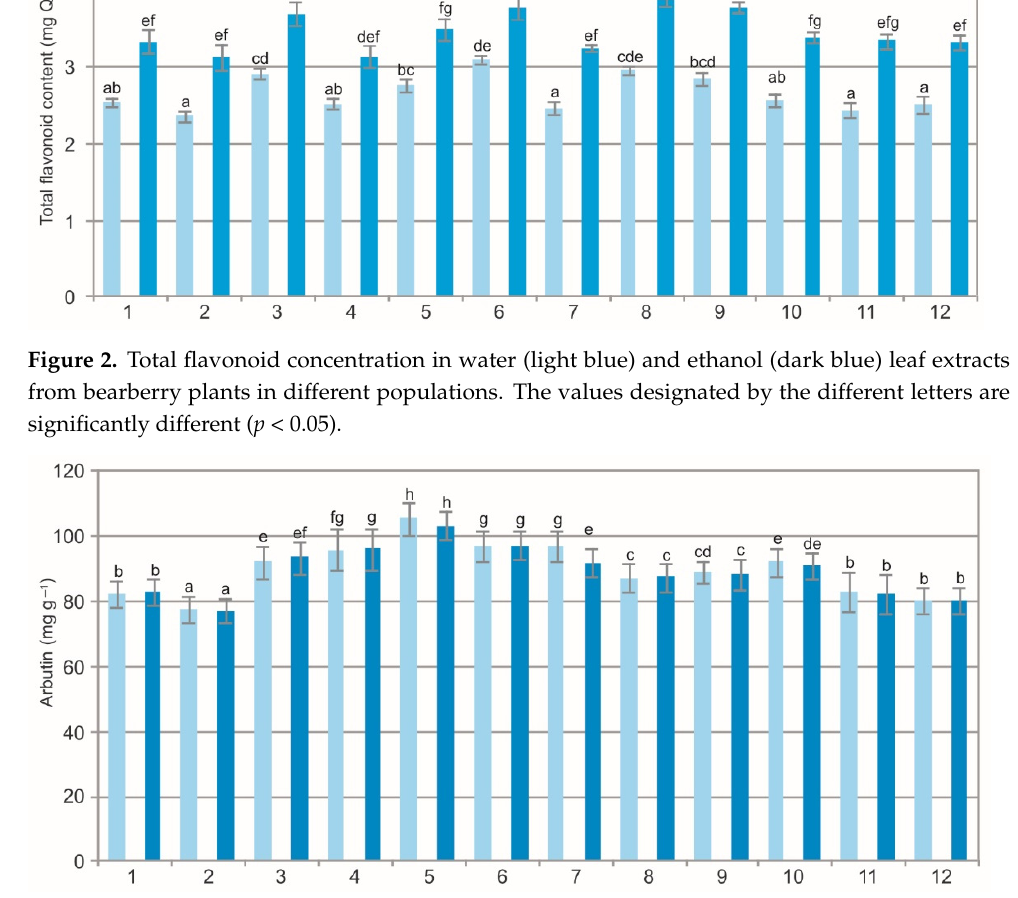
Figure 3. Arbutin concentration in water (light blue) and ethanol (dark blue) leaf extracts from bear- berry plants in different populations. The values designated by the different letters are significantly different ( p < 0.05).